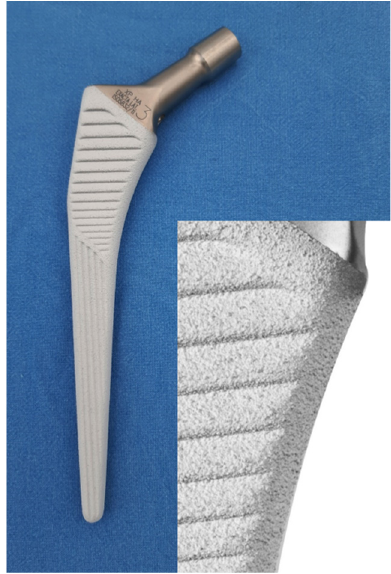
Figure 1. Image of the Exacta HAX-Pore ® femoral stem (lateralized version with +6 mm offset) and details of the plasma-sprayed porous titanium and hydroxyapatite double coating, developed by Permedica Orthopaedics, Merate, Italy.